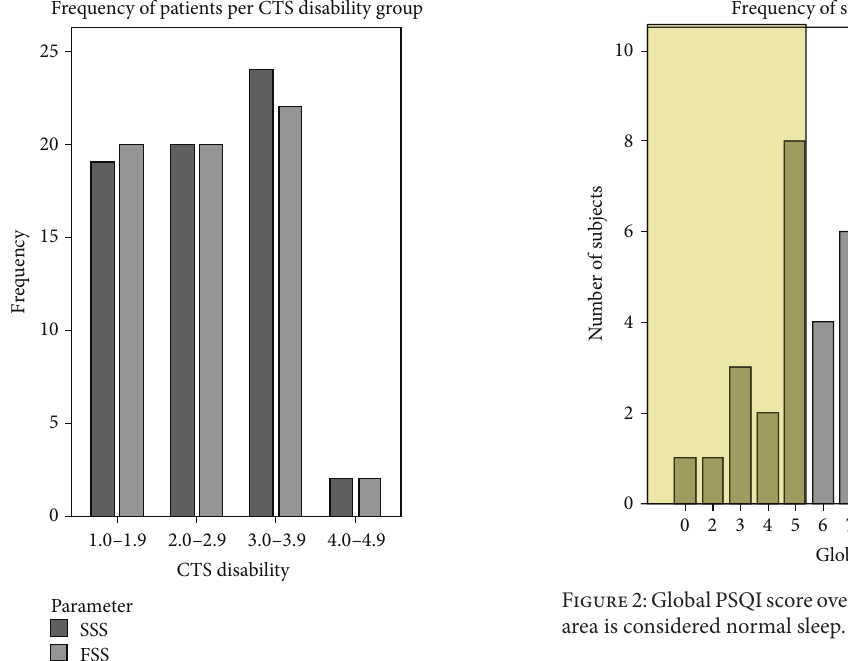
than males ( 2.8±0.91 for females versus 2.0 ± 0.69 for males). There was no difference in FSS between age strata.